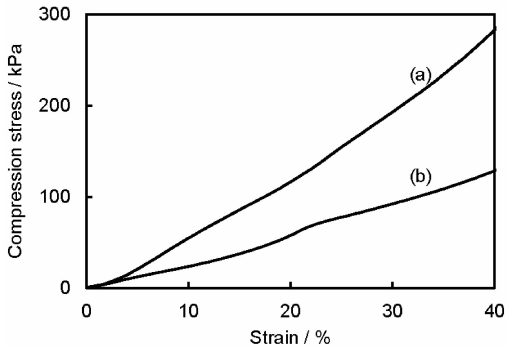
Figure 7. Compression stress–strain curves of ( a ) P3HB3HH 6 monolith (100 g ¨ L ´ 1 ) and ( b ) P3HB3HH 11 monolith (100 g ¨ L ´ 1 ).